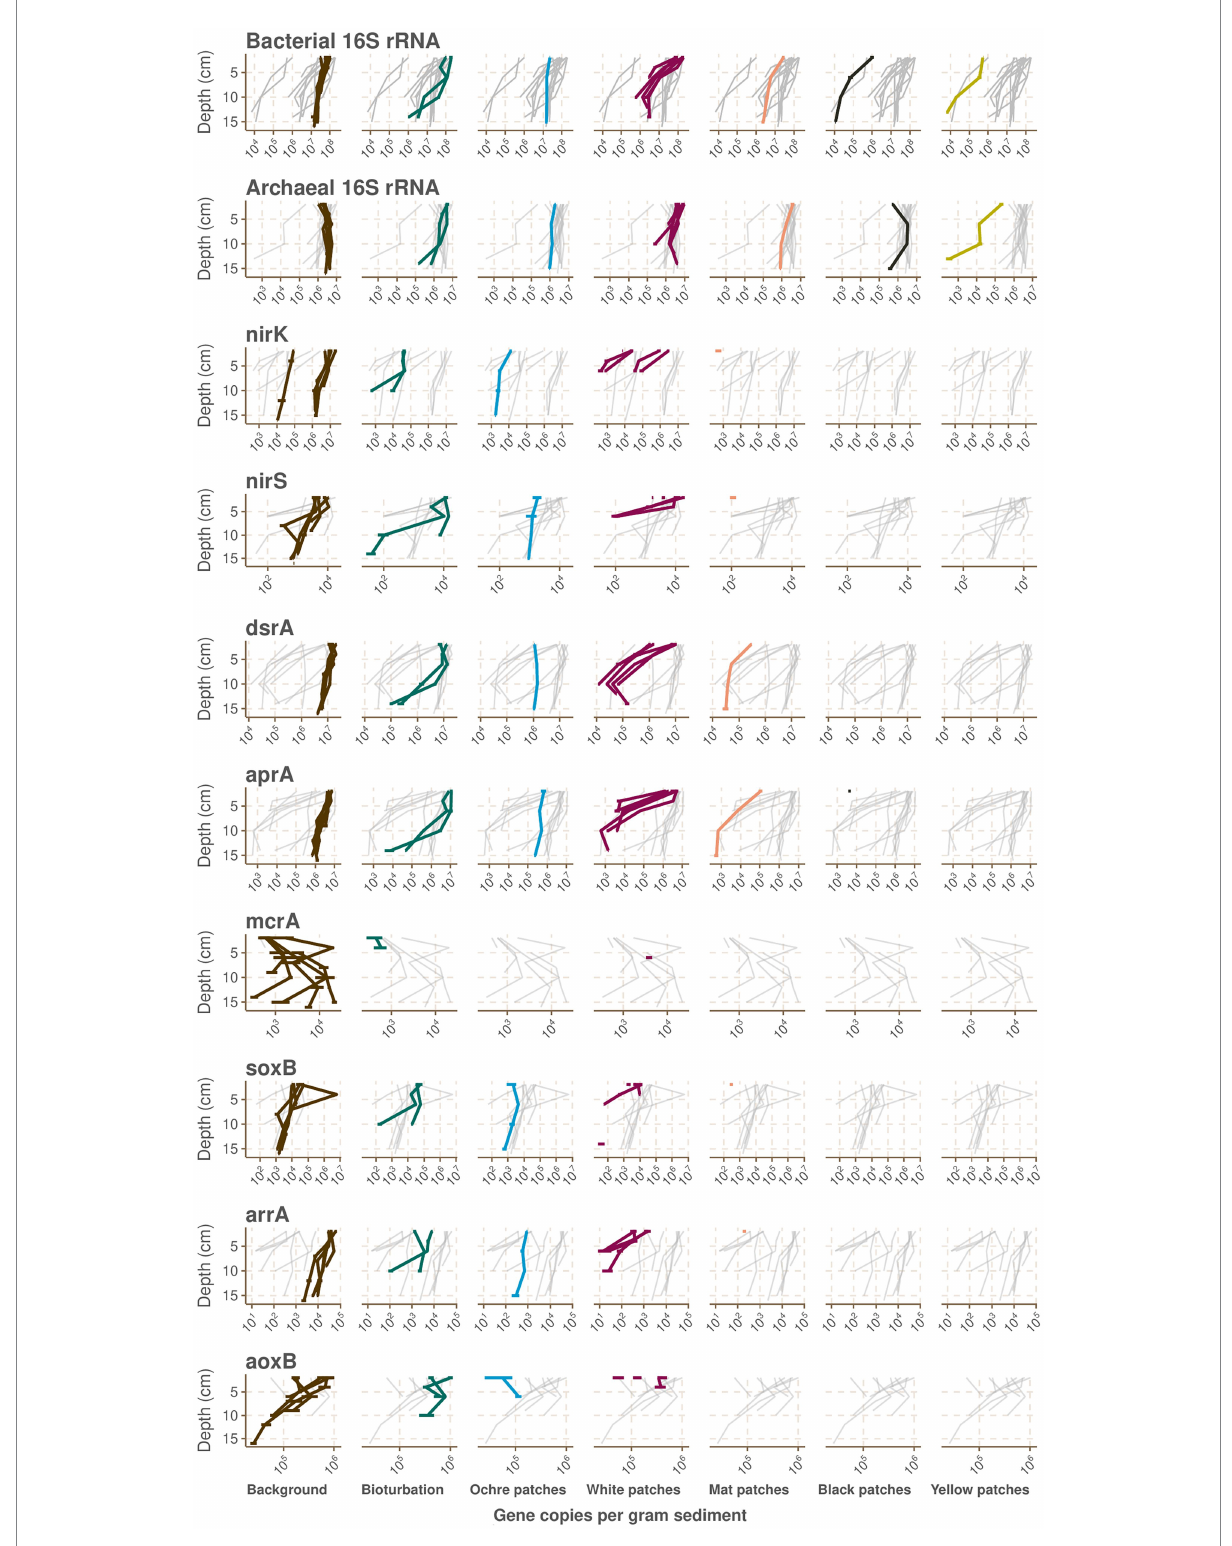
FIGURE 3 Absolute abundances per gram of sediments of various genes in the samples from the CarDHynAl dataset measured by qPCR. Samples are plotted according to their depth and their seafloor type. For each plot, the gray background lines represent the values for this gene in the other seafloor types. Horizontal error lines represent the standard deviation of qPCR